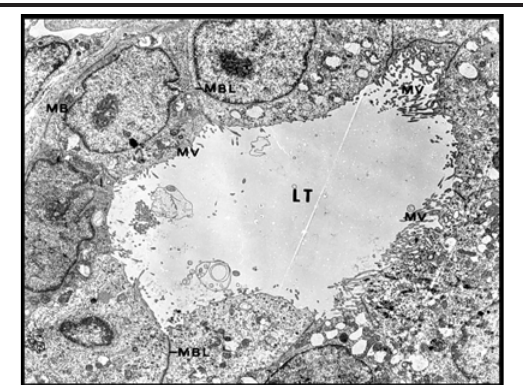
FIGURE 6 - Electronic photomicrography (12.000 X) from proximal tubular cell of the GI at the time 1 (7 days), demonstrating loss of cellular polarity with distortion and reduction in the quantity of intracellular organelles. Moderate reduction in number and height of microvilosities (board-in-brush). Cellular membrane with preserved baso-lateral invaginations. [ LT : Tubular lumen, MV : Microvilosities, MB : Basal membrane, MBL : Basolateral membrane].